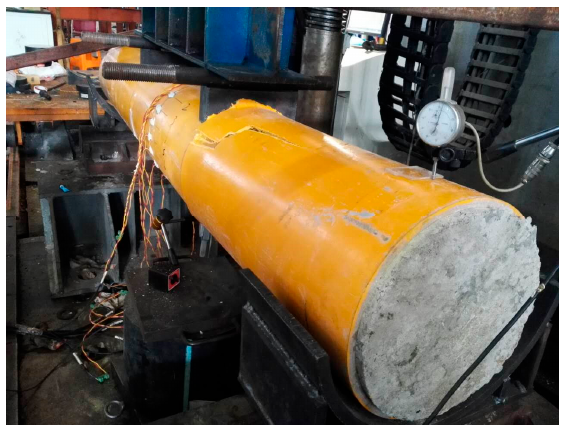
Figure 10. Failure mode of test specimen G-2000-300-12B.